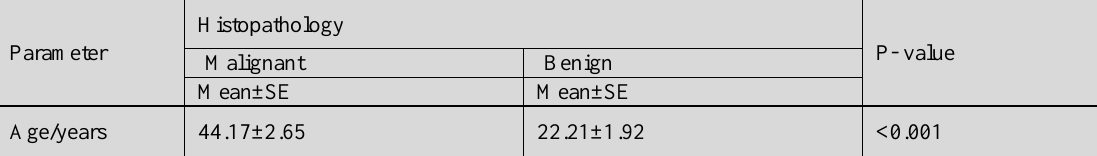
2-Gender distribution: This study showed that the number and percentage of male patients with malignant lymph nodes was 23(57.5%), while female patients were 17(42.5%) . In patients with benign lymph nodes the number and percentage of male patients were 22(53.7%) and 19(46.3%)